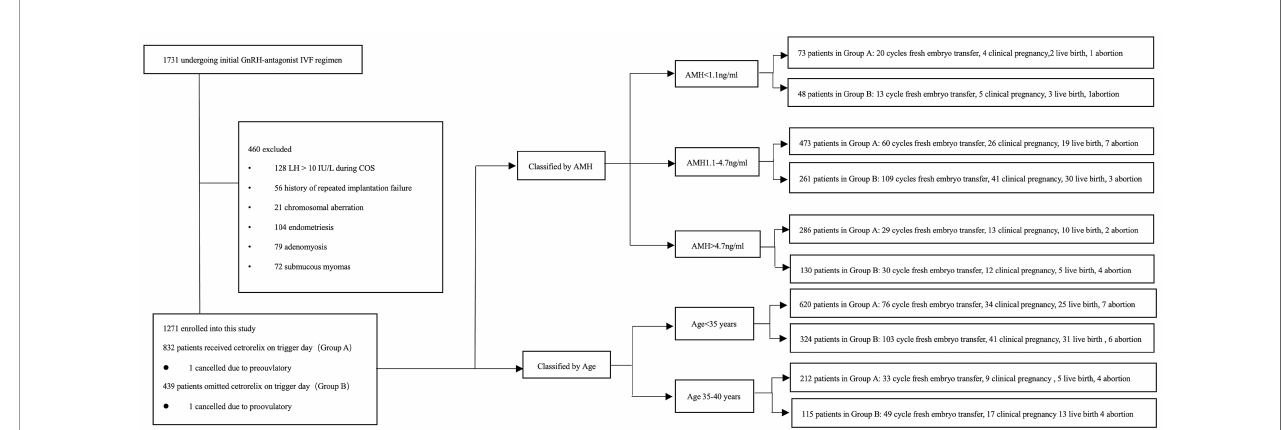
FIGURE 1 | Flowchart of this